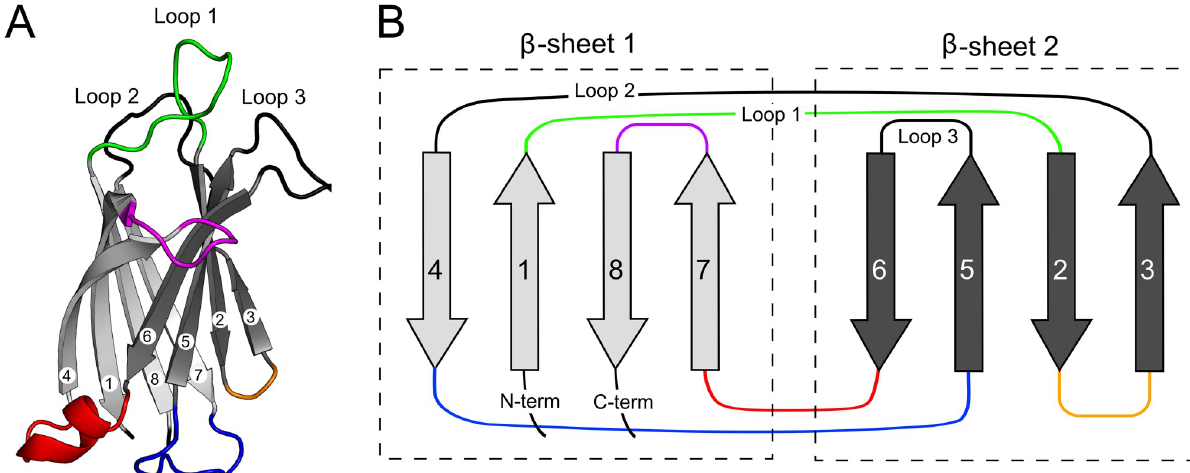
Fig 14. Schematic of Type-II C2 domain. A: Dysferlin C2A structure (4IHB) colored to highlighted the various insertions of subdomains. B: The schematic highlights the loops with embedded subdomains. The Type-2 C2 domain β -strand topology is shown as grey arrows. The colored loops: β 1–2 (green, C2C), β 2–3 (orange, C2-FerA), β 4–5 (blue, C2-FerA, C2G), β 6–7 (red, C2C, C2E, C2G, C2F), and β 7–8 (purple, C2C) show where conserved subdomains are